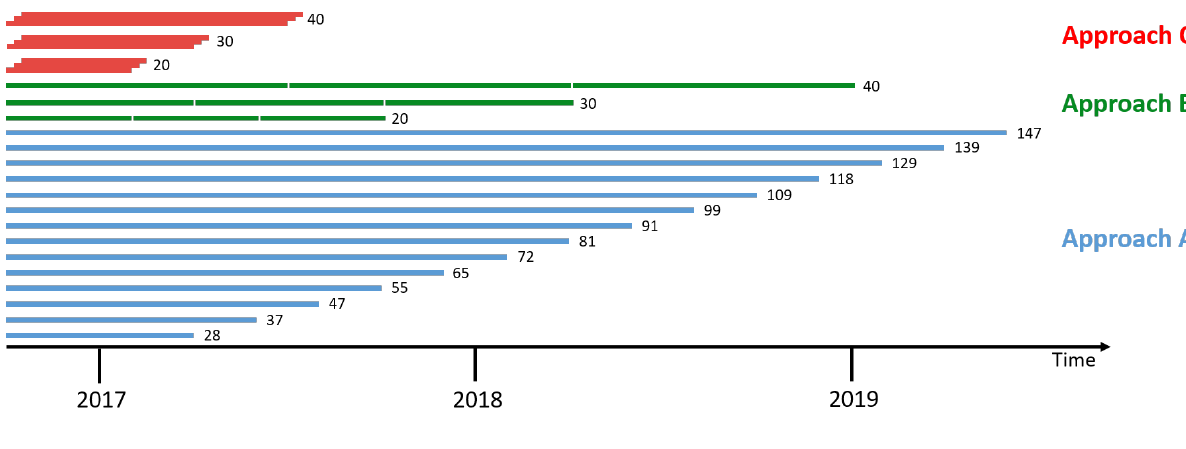
Figure 2. The three different approaches to analyze a SAR time series. influence processing time. Figure 3 illustrates their relation- ship. Both, T P (black) and N PSC (red), follow the same trend. At first, both drop significantly, while the number of images in- creases continuously. The processing time then stabilizes around 22 hours. The number of PSC continues to decrease, however, at a much smaller rate. The outlier in the T P graph is most likely due to background process of the server, which we used to con- duct this study. The similar curve progression of T P and N PSC indicates, that N PSC has more influence on the processing time than the number of images.